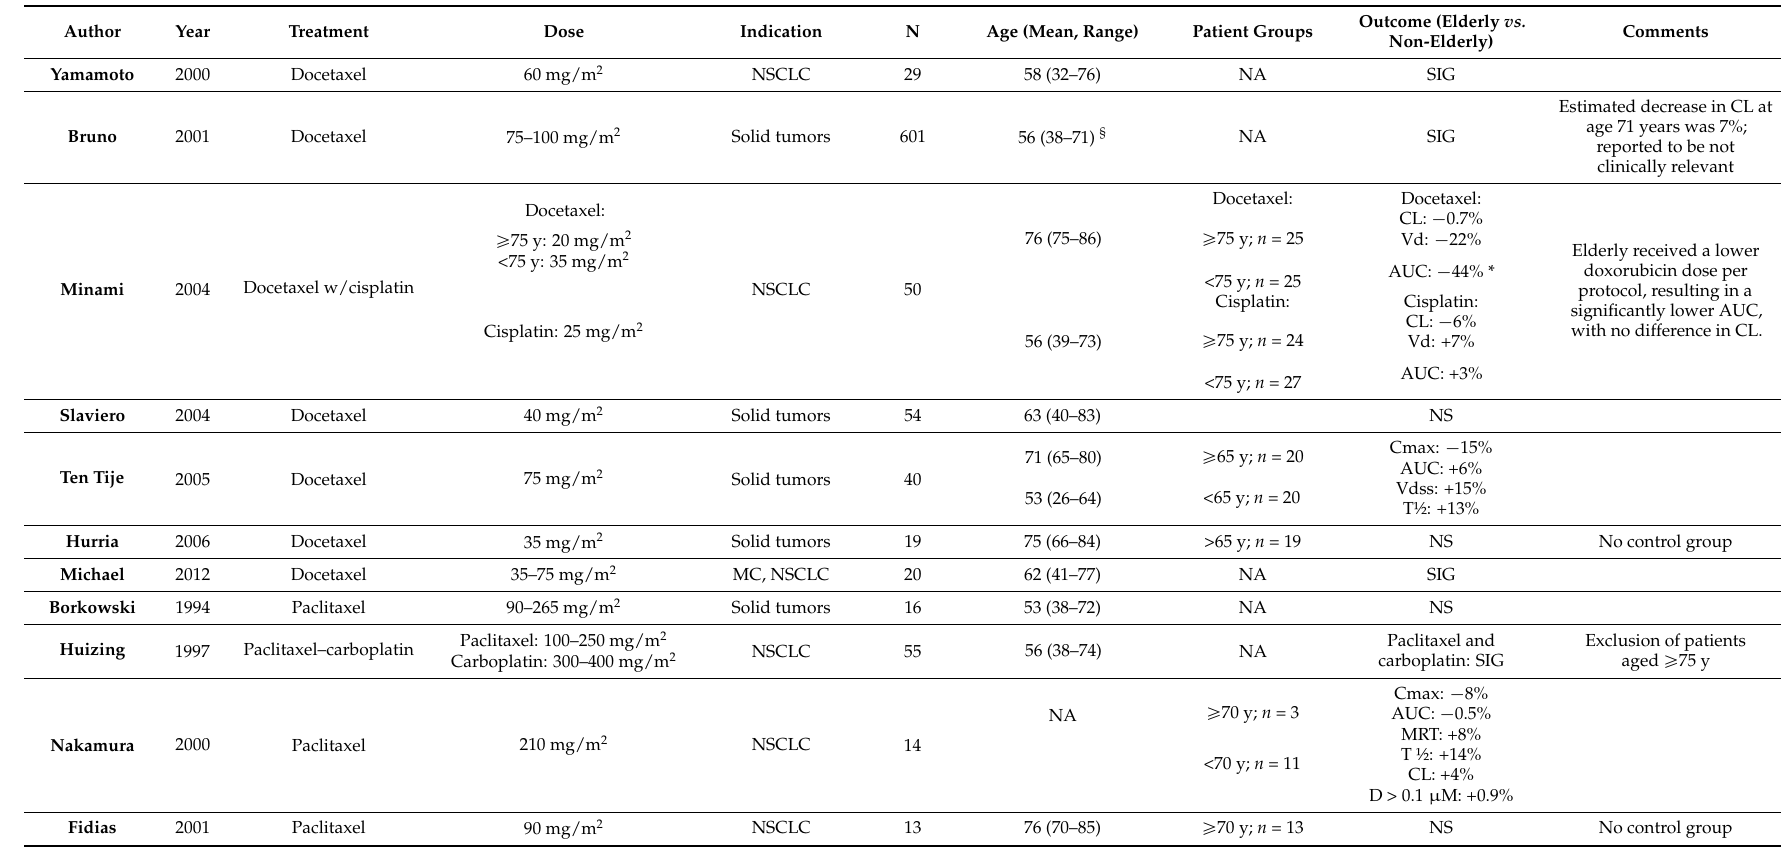
Table 2. Overview of studies assessing the pharmacokinetics of anticancer drugs in elderly